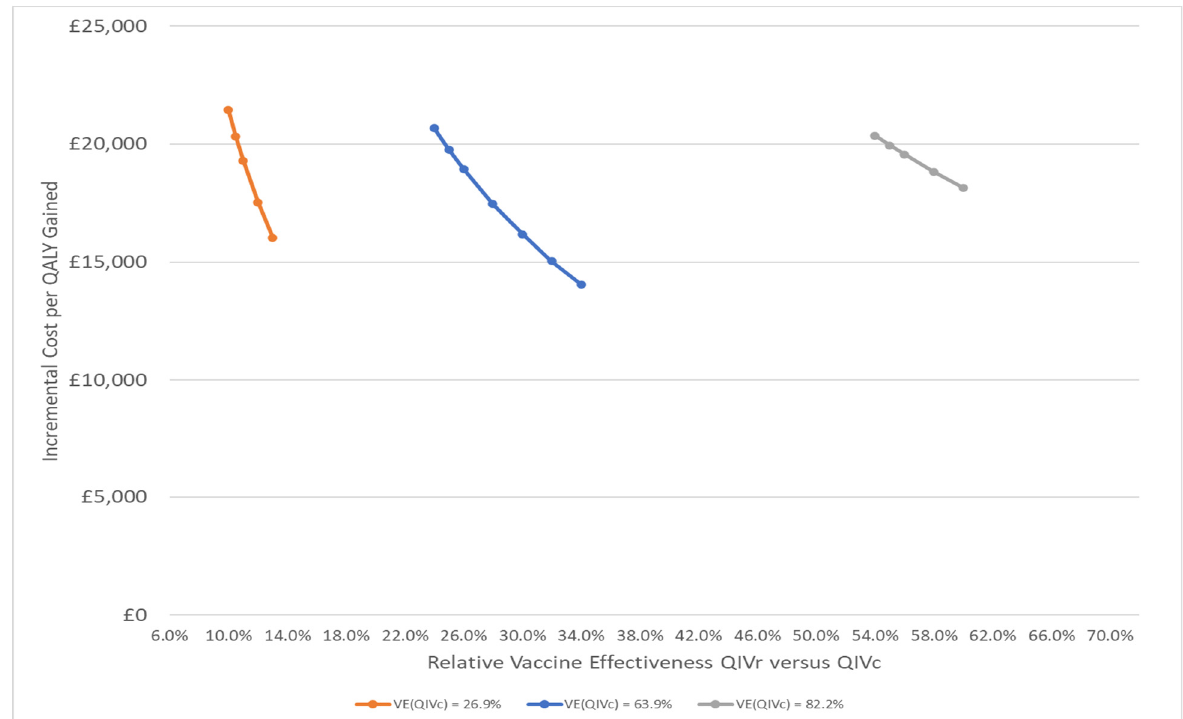
Figure 1. Impact of relative vaccine effectiveness on the incremental cost per quality-adjusted life-year (QALY) gained of QIVr compared to QIVc for different levels of absolute effectiveness (VE) of QIVc.